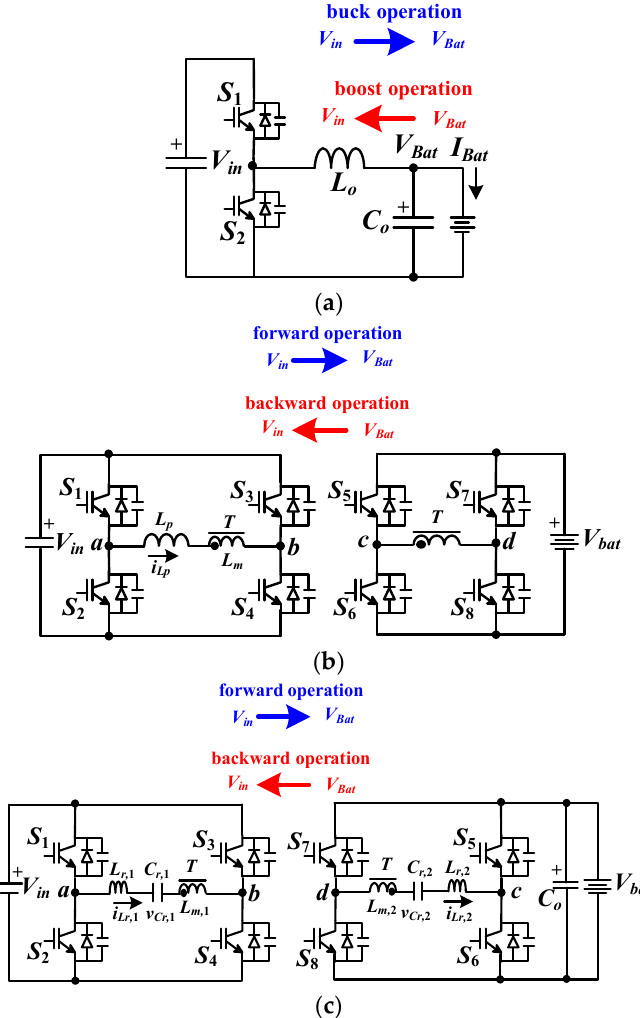
Figure 2. Circuit diagrams of bidirectional DC/DC converter: ( a ) buck/boost converter; ( b ) dual active bridge converter; ( c ) dual resonant converter.